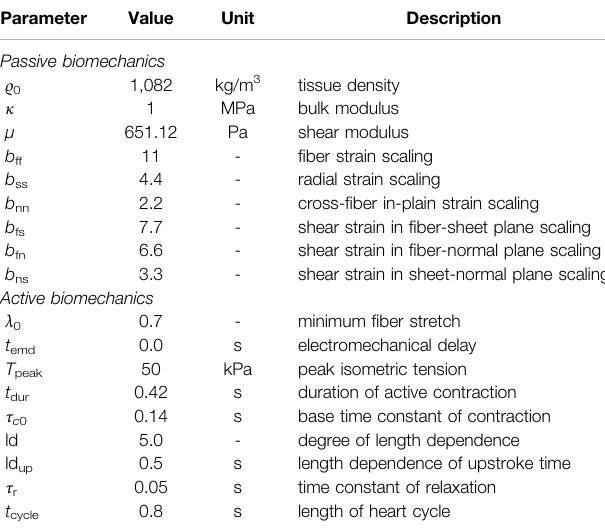
( C − I ) , bulk modulus κ , shear 2